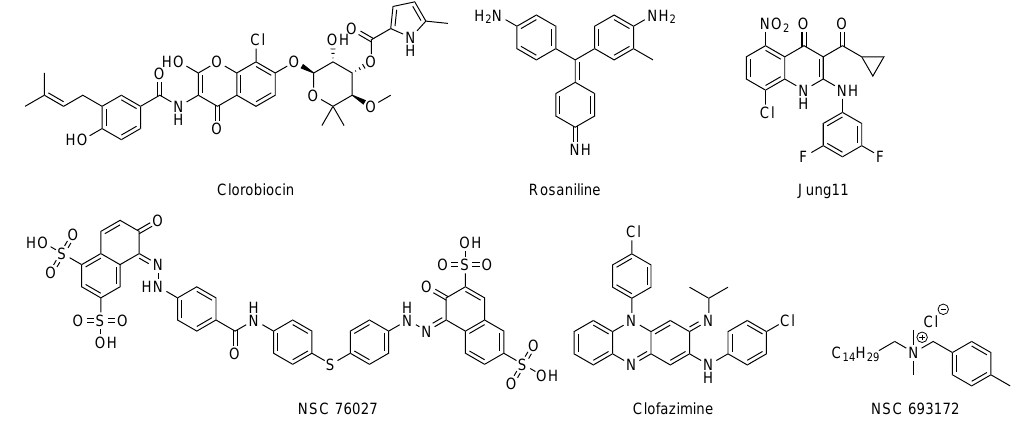
Figure 12. Current reported inhibitors of SerB2 or close